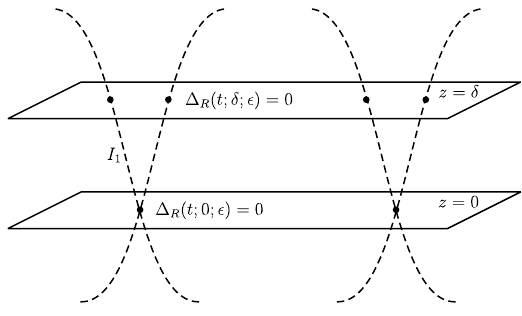
Figure 3 . For IV ns and IV (cid:3) , upon turning on (cid:14) , the residual discriminant intersection further ns splits into 2 components along the z = (cid:14) plane. The monodromy induced by a path around both, which coalesces into the monodromy around a single component in the z = 0 plane, is the one relevant for reducing to the gauge